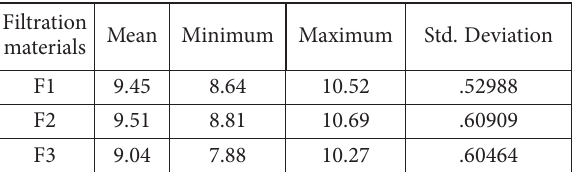
Table 3. pH values according to filtration materials Filtration Mean Minimum Maximum materials